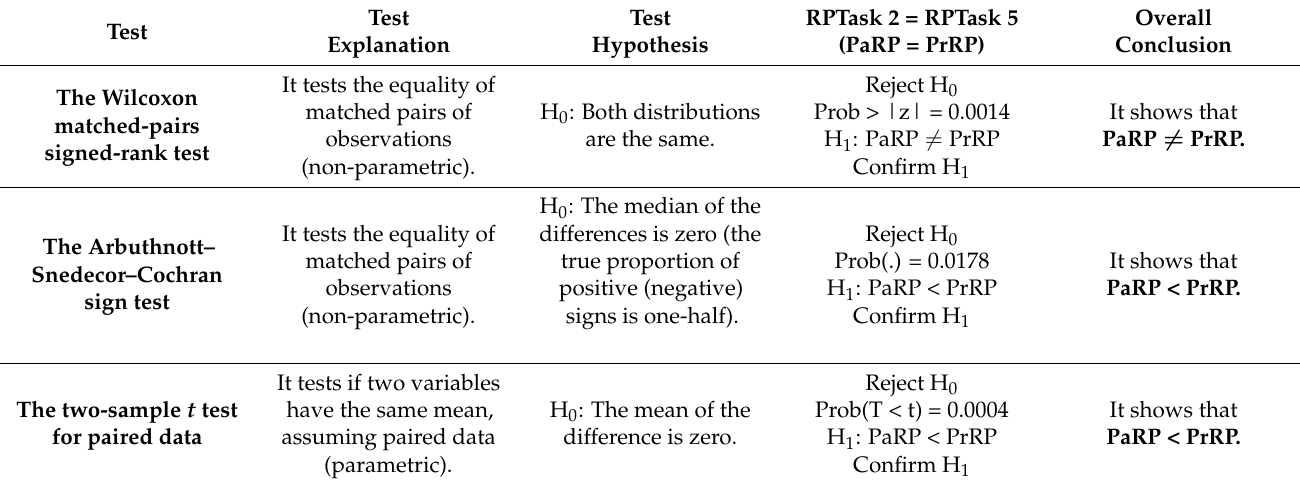
Table 3. Summary of the results of three statistical tests on risk